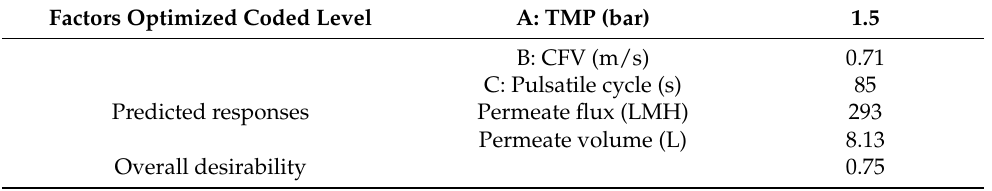
Figure 9. Independent factors ranges, response criteria, and desirability solution for the membrane permeate flux and permeate volume. Table 14. Optimization results for the membrane permeate flux and permeate